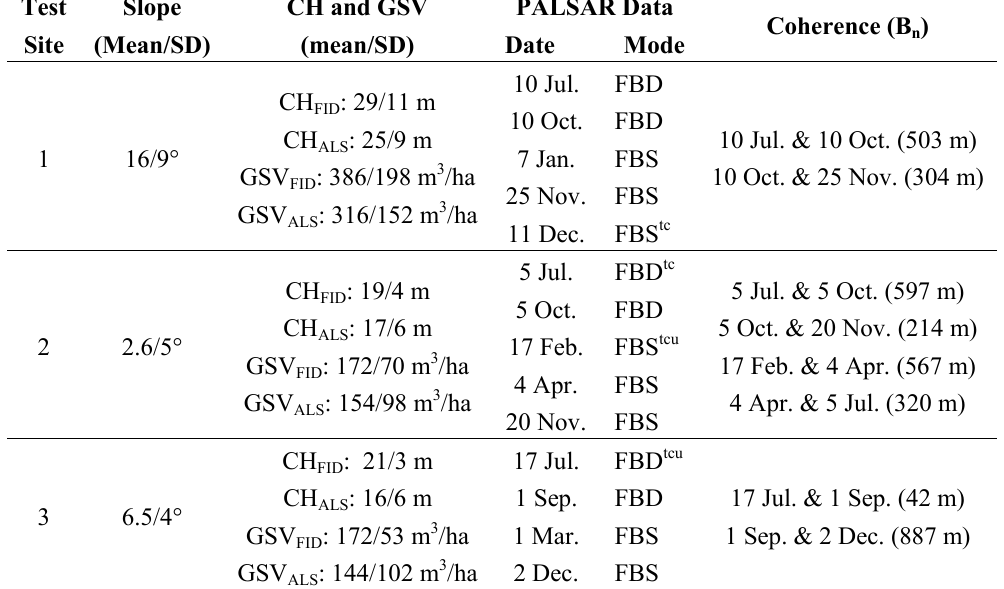
Table 2. Properties of forest in inventory stands (FID) and segments derived from the ALS CHM (CH and GSV estimates from ALS) and the ALOS SAR/InSAR imagery available at each test site. PALSAR acquisitions for which the weather stations in Concepcion, Temuco or Curico reported rainfall (>1 mm) in the two days prior to the sensor overpasses are marked with superscript indices ‘c’, ‘t’ and ‘u’,